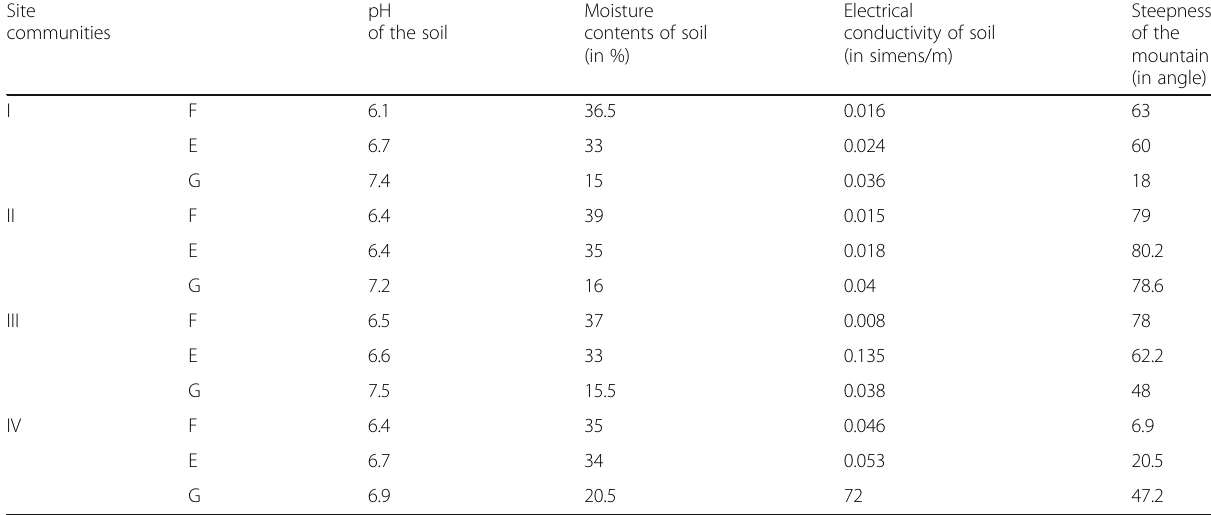
Table 2 Environmental variables at different sites among three communities Site communities